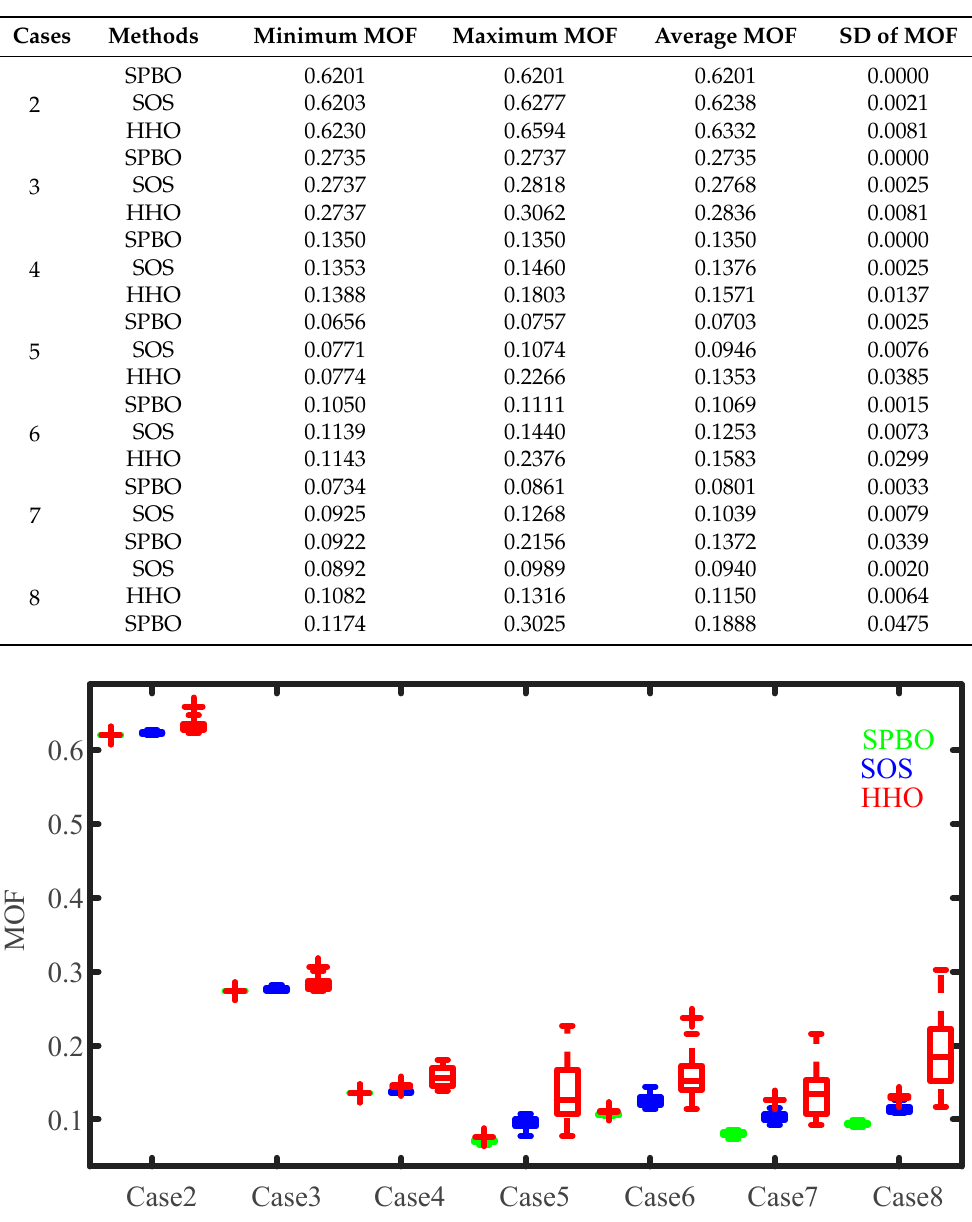
Figure 10. Box plots for 33-node test system.